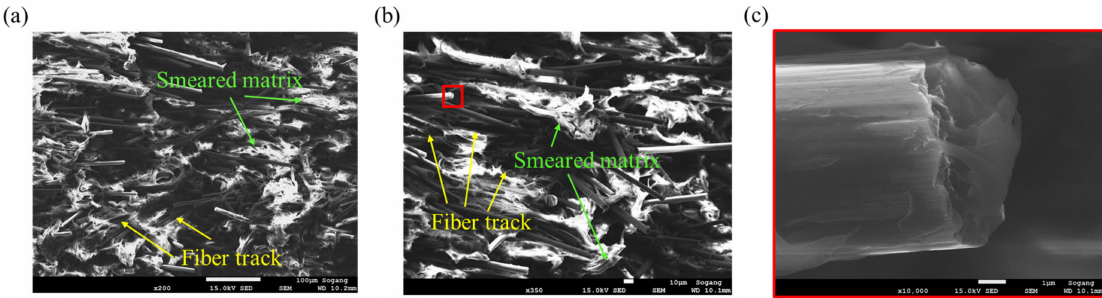
Figure 16. Fracture mechanism observed for θ = 45 ◦ compressive specimen: ( a ) smeared matrix and fiber tracks (magnification: × 200, scale: 100 µ m), ( b ) smeared matrix and fiber tracks (magnification: × 350, scale: 10 µ m), ( c ) fracture surface of fiber due to flexural failure (magnification: × 10,000, scale: 1 µ m).